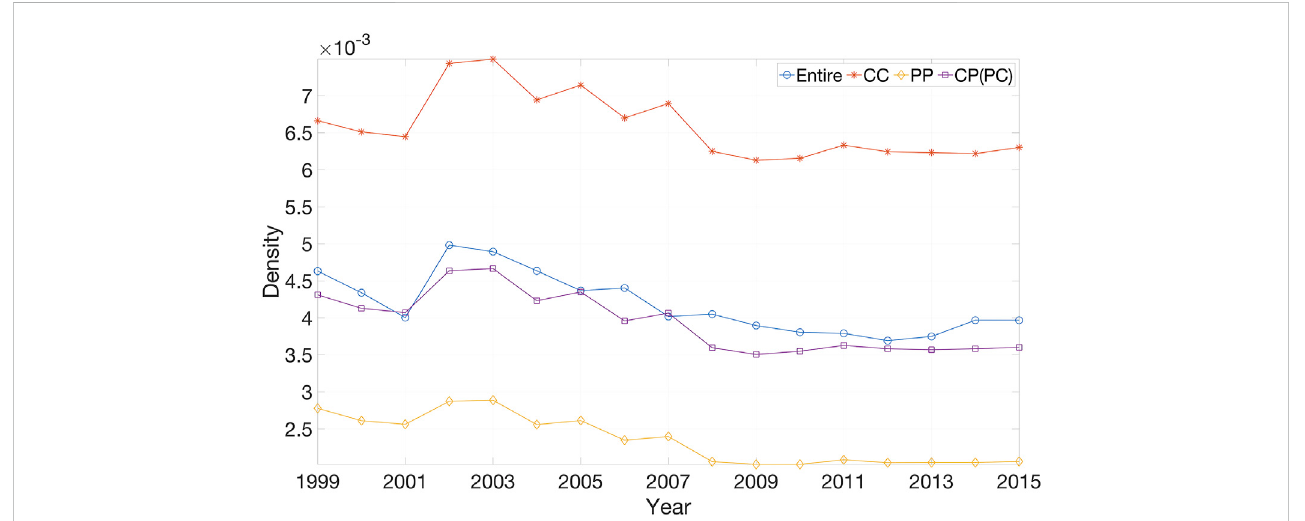
FIGURE 7 Density of a random network of 100 simulations, CC/PP/CP(PC) blocks. The de fi nition of CCP/PP/CP(PC) blocks is explained in Figure 2. In the simulation, there are no large differences between the density of the core – core block and the density of the periphery and core – periphery blocks.